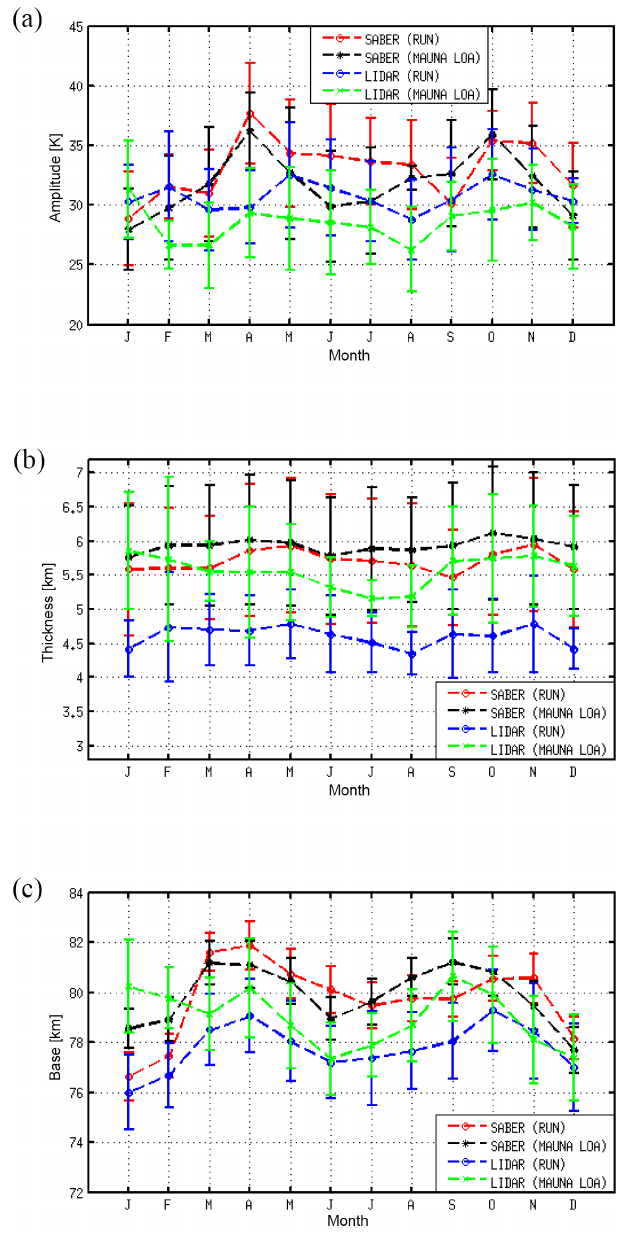
Figure 4. Time evolution of monthly averaged (a) amplitude, (b) thickness and (c) base of the inversion layer obtained from li- dar and SABER observations during 1994–2009 over Réunion (red line) and during 1993–2015 over Mauna Loa (black